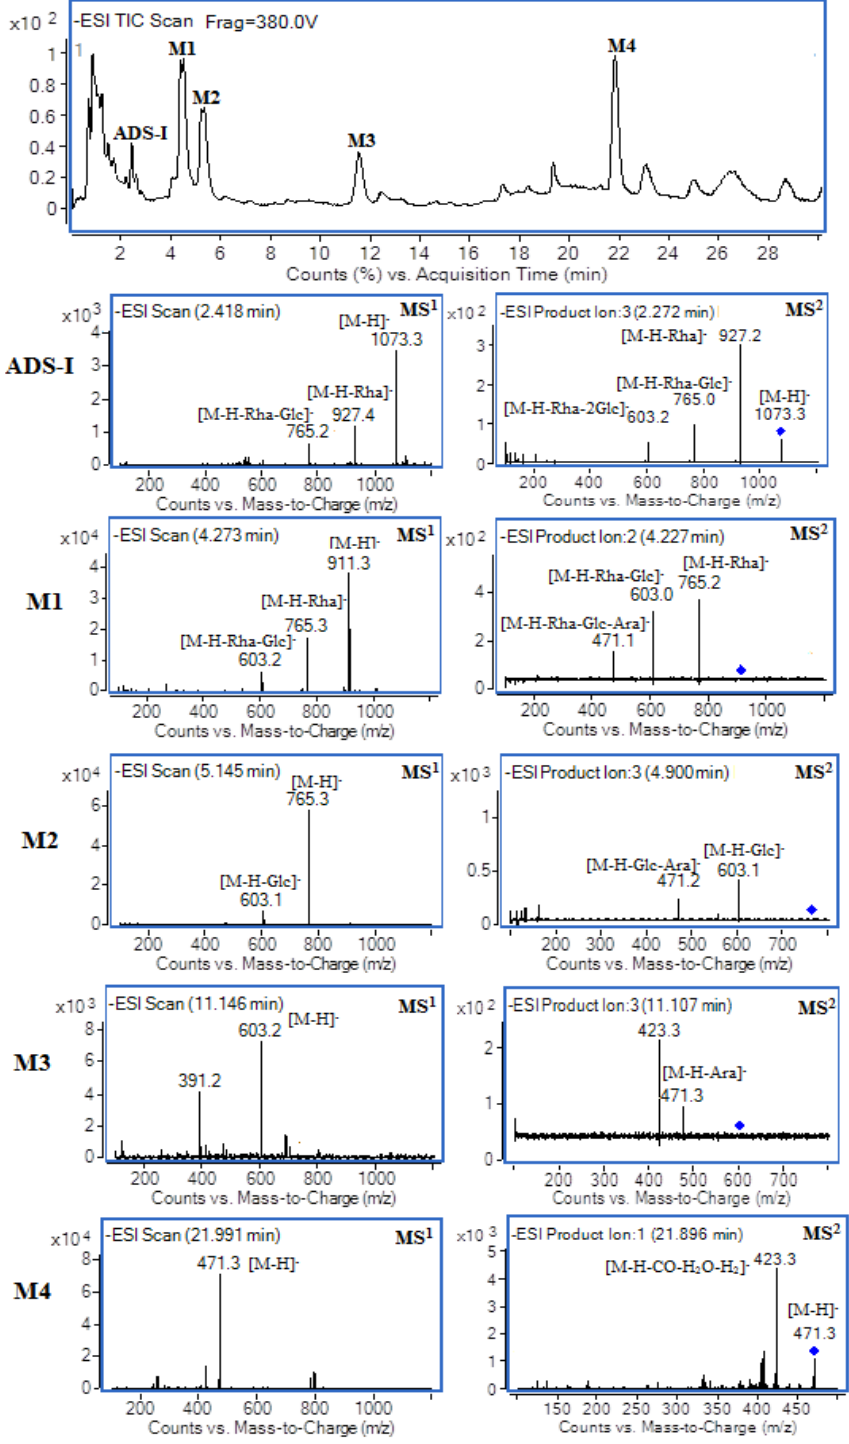
Figure 3. The typical total ion chromatogram and mass spectra (MS 1 and MS 2 ) of ADS-I and its metabolites formed by human intestinal bacteria.